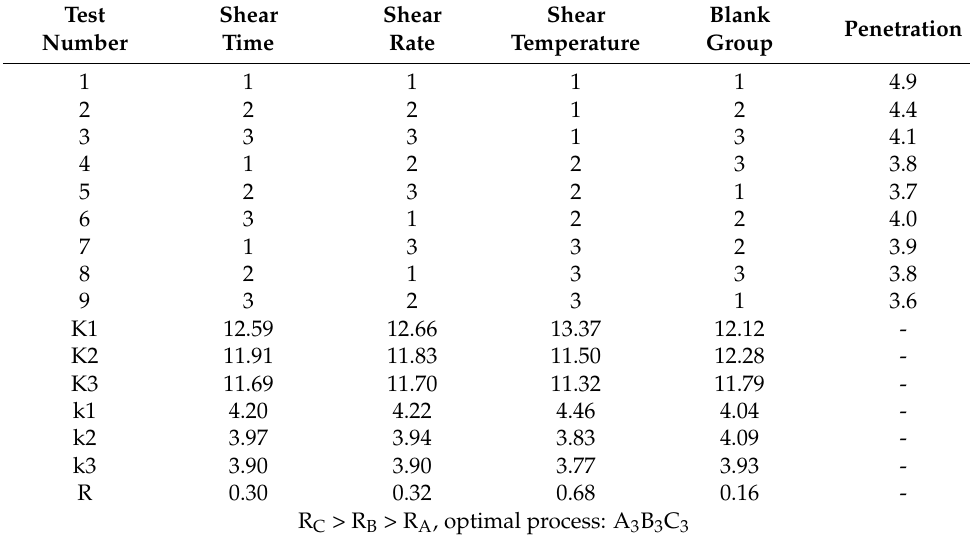
Table 7. Penetration range analysis